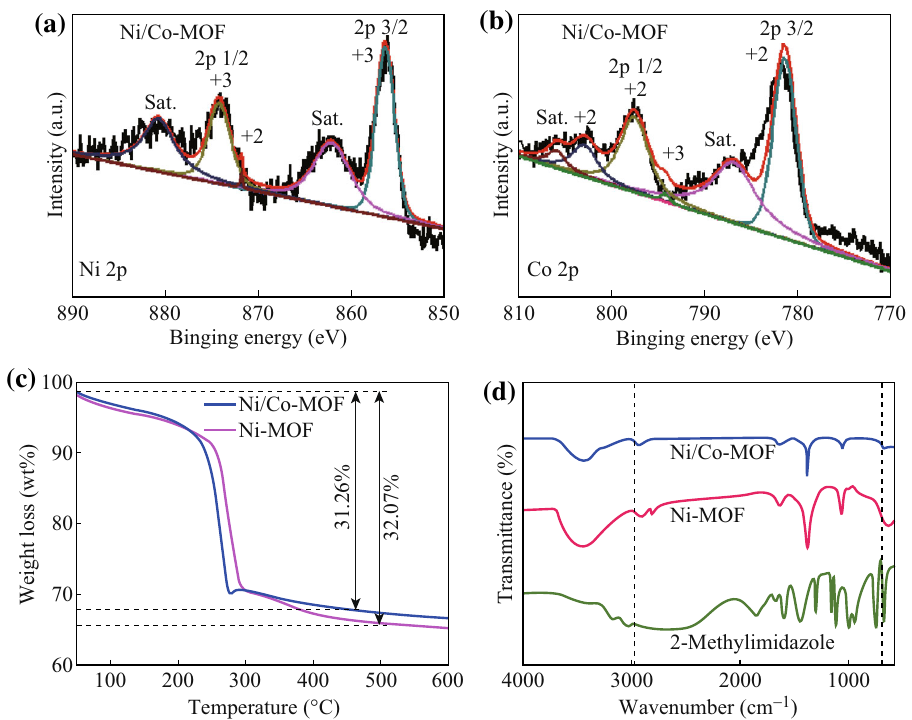
Fig. 2 a Ni 2 p XPS spectra and b Co 2 p spectra of Ni/Co-MOF nanoflakes. c TGA of Ni/Co-MOF nanoflakes and Ni-MOF nanoflakes. d FTIR spectra of Ni/Co-MOF nanoflakes, Ni-MOF nanoflakes, and